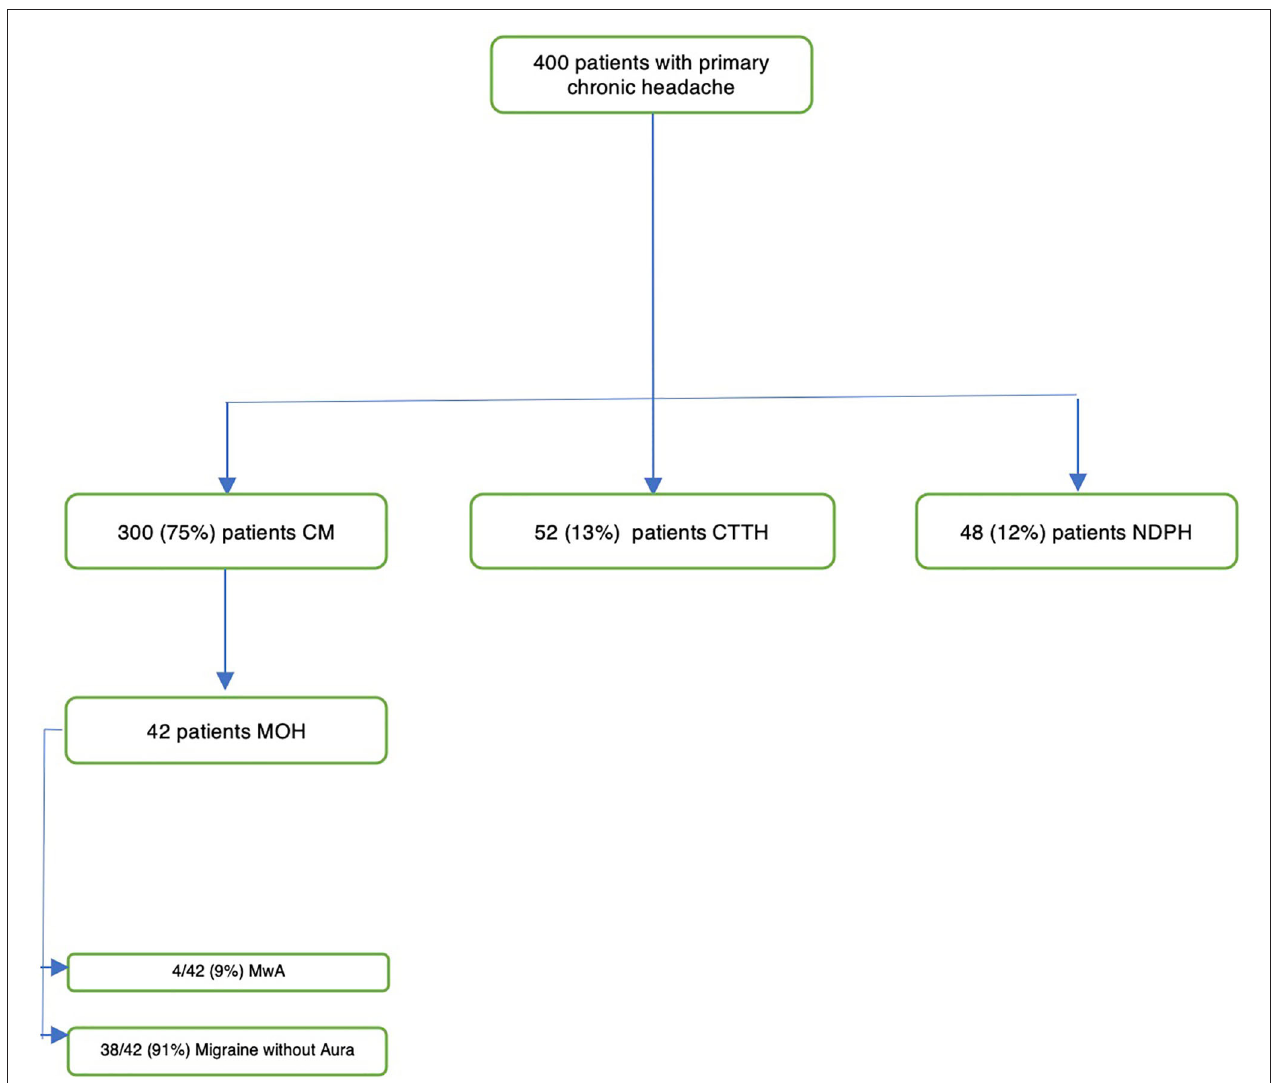
FIGURE 1 | Flowchart showing patients’